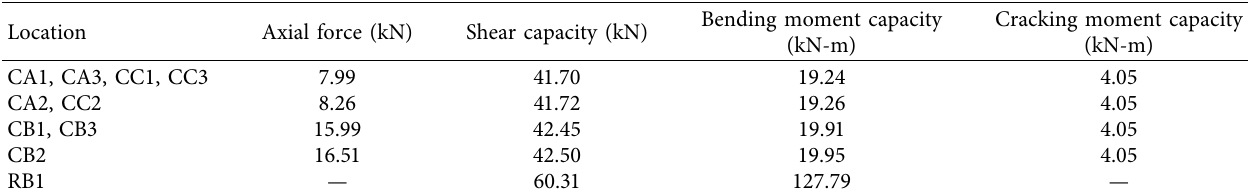
Figure 5: Bare frame model. Table 2: Axial force, shear strength, and bending moment of columns and beams.